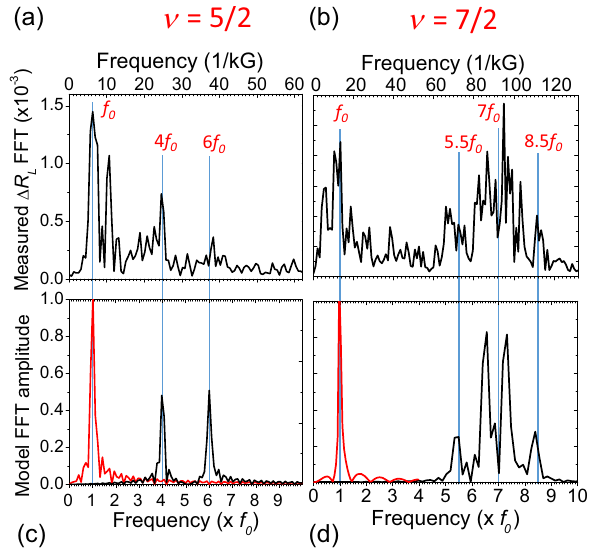
FIG. 13. Modeling FFT spectra at ν ¼ 5 = 2 and 7 = 2 . In a magnetic field sweep at ν ¼ 5 = 2 and ν ¼ 7 = 2 , rapid oscillations due to the even-odd effect will be modulated by slower oscillations due to e= 4 - e= 2 interference. At ν ¼ 5 = 2 this implies modulating oscillations at 5 f 0 by oscillations at f 0 , resulting in peaks at 4 f 0 and 6 f 0 . At ν ¼ 7 = 2 , 1 . 5 f 0 modulation of 7 f 0 even- odd oscillations should produce peaks at 5 . 5 f 0 and 8 . 5 f 0 . Panels (a) and (b) show measured power spectra at these filling fractions: (a) ν ¼ 5 = 2 , sample 2, preparation 2 [same as in Fig. 11(b)]; (b) ν ¼ 7 = 2 , sample 6, preparation 15, device type b; T ∼ 20 mK in both cases. The measured power spectra are compared with simple models. The black trace in panel (c) is the FFT of the expression Δ R cos ð 2 π Bf 0 Þ × L ¼ cos ½ 2 π B ð 5 f 0 Þ(cid:5) taken using the magnetic field window similar to the one used to obtain power spectra in the experiment. The red trace is the FFT of Δ R cos ð 2 π Bf 0 Þ demonstrating L ¼ the f 0 oscillation peak. The spectra are scaled to match the locations and amplitudes of their peaks at frequency f 0 . Panel (d) shows a similar modulation of the 7 f 0 even-odd oscillations by 1 . 5 f 0 oscillations expected for the e= 4 - e= 2 interference at ν ¼ 7 = 2 . In addition, the minima of R are reproducibly formed L away from the reentrant quantum Hall phases in the high-quality material used in this study, resulting in an additional low- frequency modulation at about 0 . 4 f 0 . To capture these effects, 0 . 25 cos ½ 2 π B ð 0 . 4 f we model the resistance as Δ R 0 Þ(cid:5)þ L ¼ f 0 . 75 cos ½ 2 π B ð 1 . 5 f 2 π B ð 7 f 0 Þ(cid:5)g × cos ½ 0 Þ(cid:5) . The FFT of this expres- sion results in the spectrum shown in panel (d), compared directly to measured data at ν ¼ 7 = 2 in panel (b). Again, a FFT of Δ R cos ð 2 π Bf 0 Þ is the red trace panel (d). (See also Supple- L ¼ mental Material Sec. S5g and Fig. S5-23 show the observed and modeled spectra at ν ¼ 5 = 2 where only the modulation due to e= 4 - e= 2 interference is taken into account.